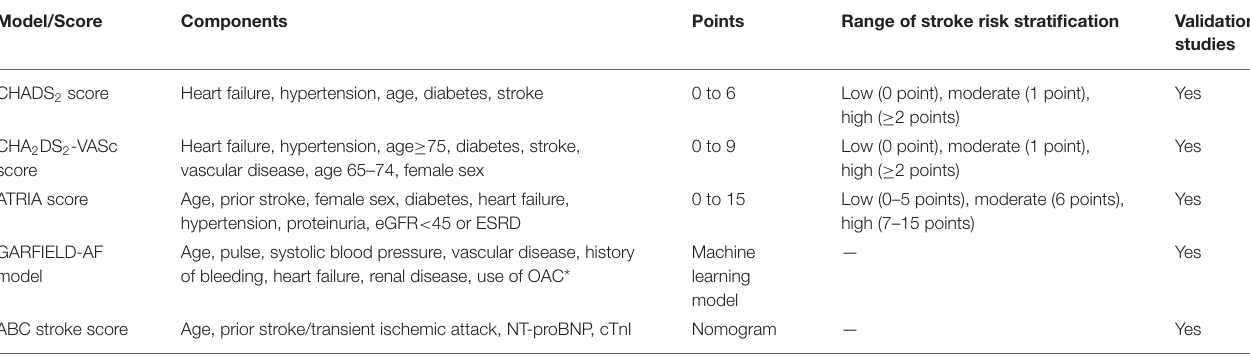
TABLE 1 | Influential IS risk stratification models/scores for